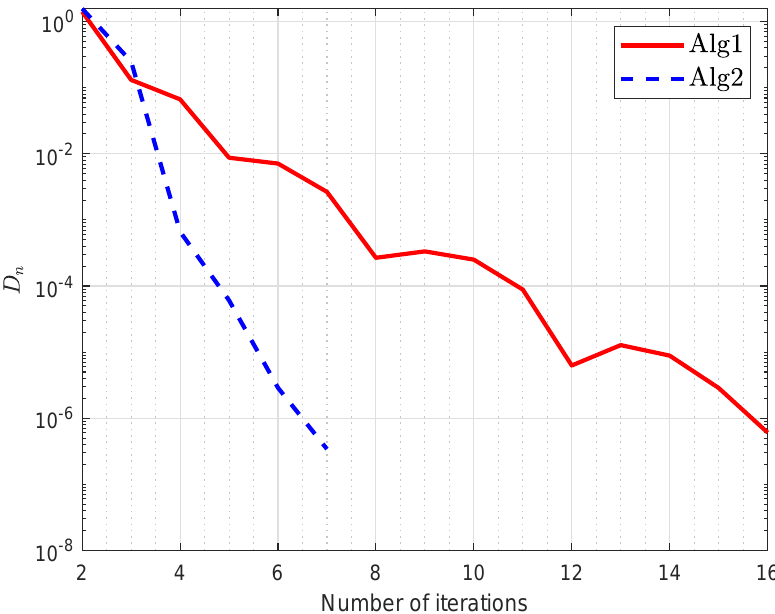
Figure 1. Example 4: Algorithm 1’s numerical comparison with Algorithm 1 in [19] by letting u − 1 = u 0 = ( 1.7,1.9 ) .